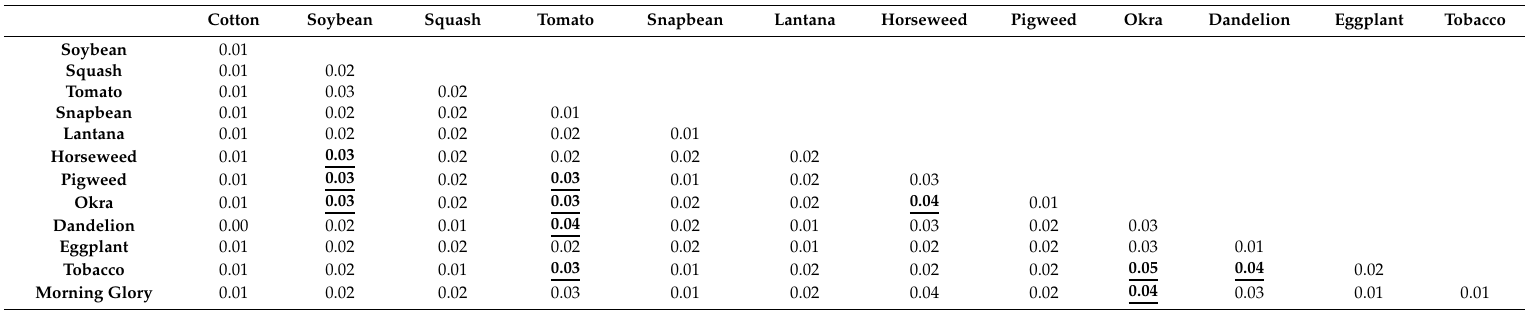
Table 7. Pairwise F ST values among B. tabaci MEAM1 populations collected from di ff erent host plants based on six microsatellites markers.